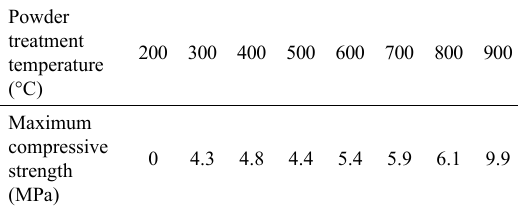
Table 1. Compressive strength of Na-geopolymers produced from powders heat treated at different temperatures. Powder